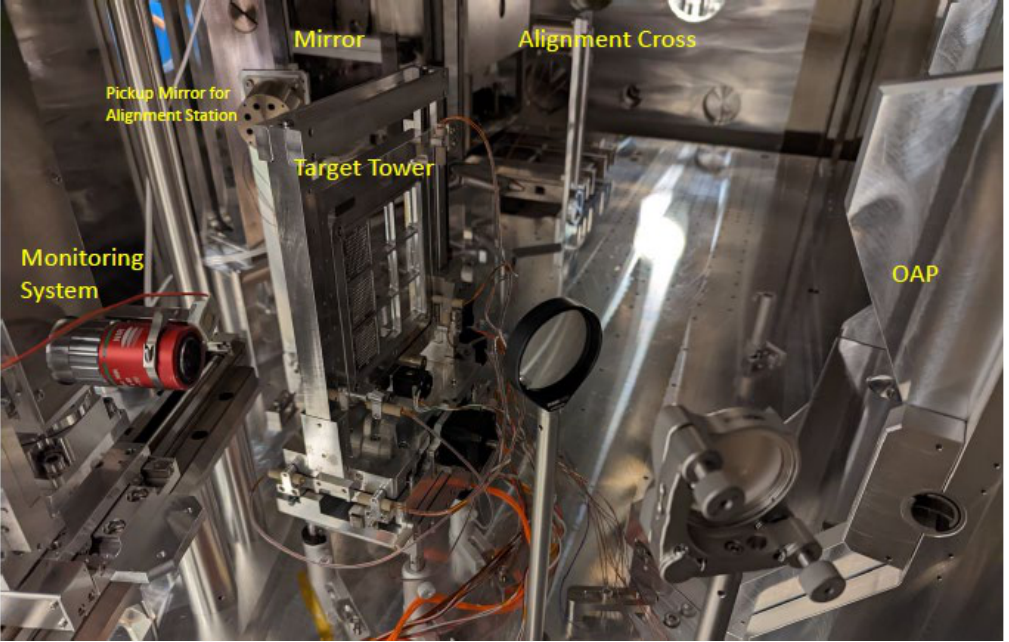
Figure 13. Photo showing details of the interaction area in the ECU D2 interaction chamber.